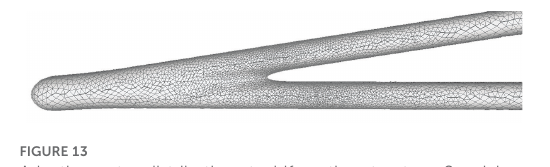
FIGURE13 Adaptive vertex distribution at a bifurcating structure. Special care is taken at the separating position to create smooth high-curvature surfaces.